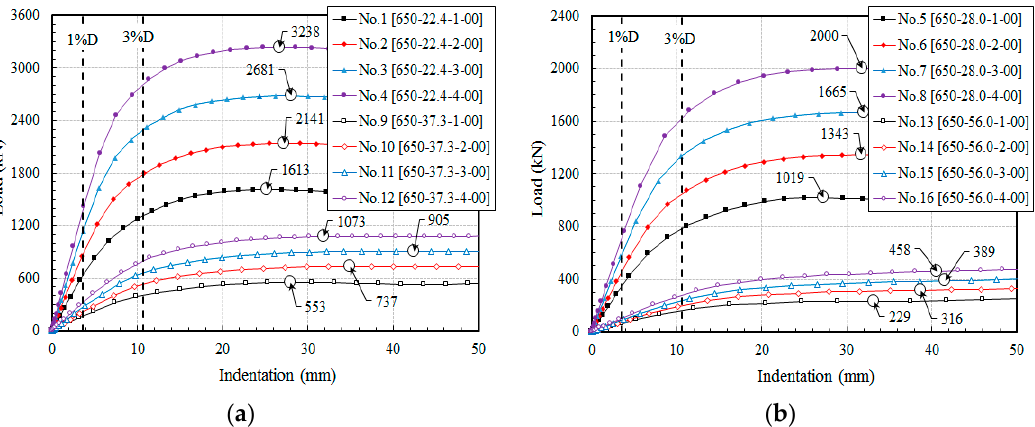
Figure 10. Load–indentation curves of HSA800 ( F y = 650 MPa): ( a ) 2 γ of 22.4 and 37.3; ( b ) 2 γ of 28.0 and 56.0.